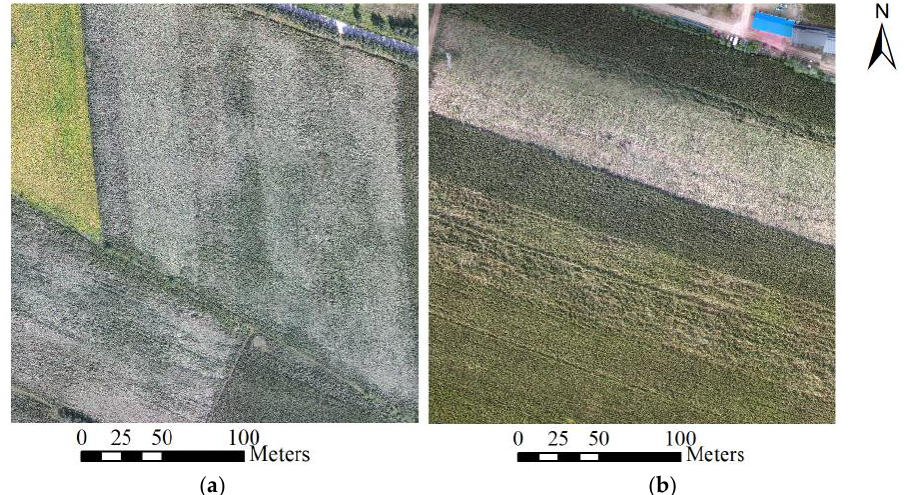
Figure 2. UAV images collected during the field campaign. The field of North-south ( a ) and east-west ( b ) orientations.